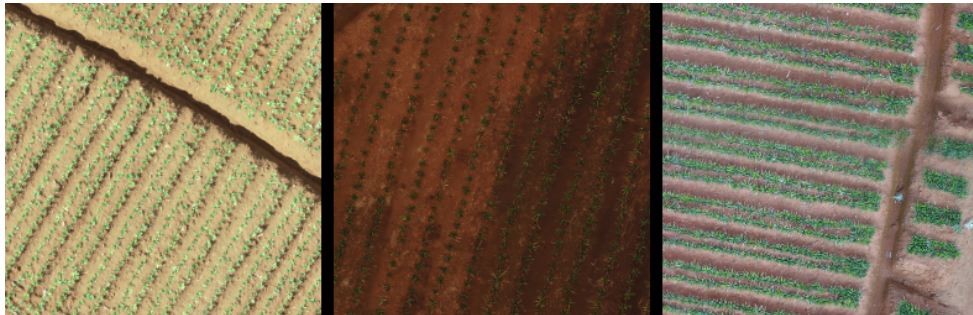
Figure 1. Domain gap between different crop domains in the pineapple dataset. The images in each column belong to a different crop domain, characterized by different lighting conditions, plant growth stages, soil types, and other factors. The significant variations between domains pose a challenge for traditional fully supervised methods, which struggle to generalize across